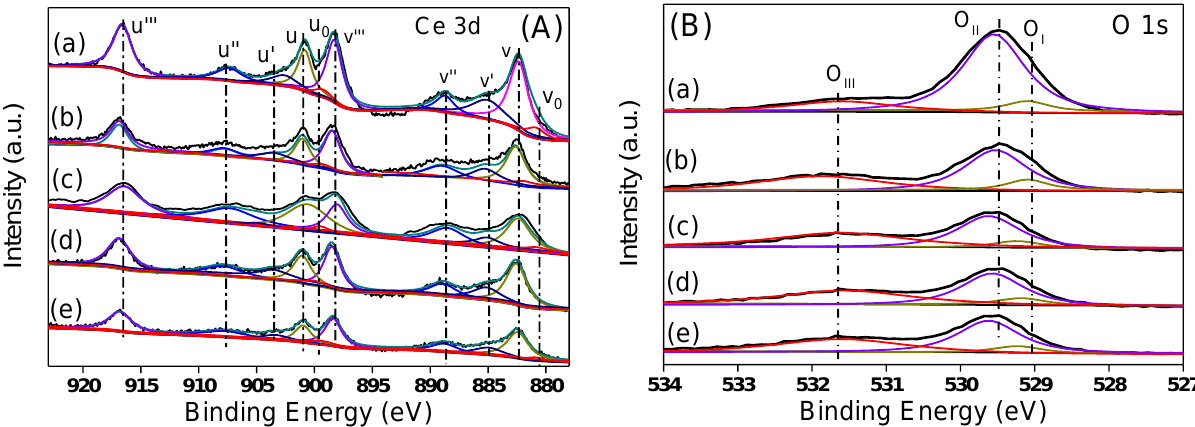
Figure 6. The ( A ) Ce 3d and ( B ) O 1s core-level XPS spectra of the xNi/CeO 2 catalysts (a) CeO 2 , (b) 5Ni/CeO 2 , (c) 10Ni/CeO 2 , (d) 17.5Ni/CeO 2 , and (e) 30Ni/CeO 2 . Table 2. The quantitative analysis of XPS for reduced xNi/CeO 2 catalysts. Sample